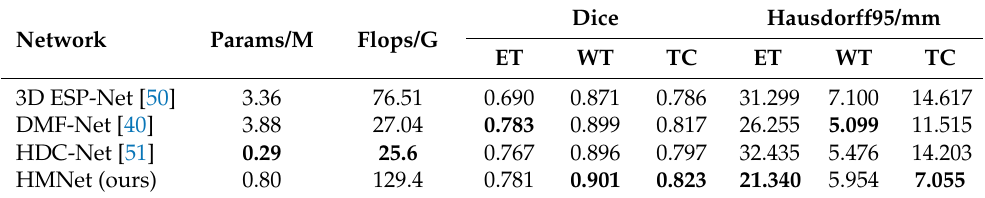
Table 5. Comparison with other lightweight brain tumor segmentation networks on the BraTS 2020 validation